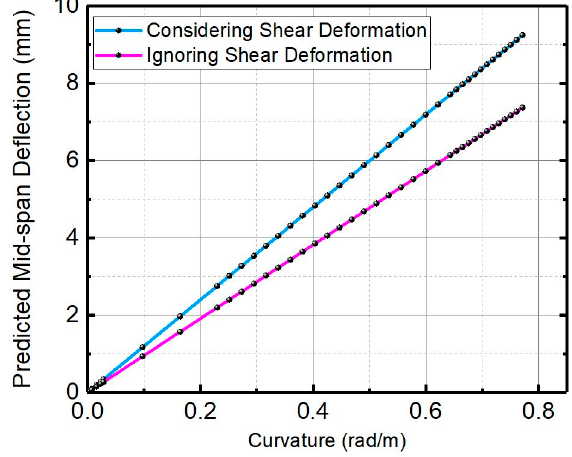
Figure 7. The procedure to obtain the load-total deflection in a four-point beading test.